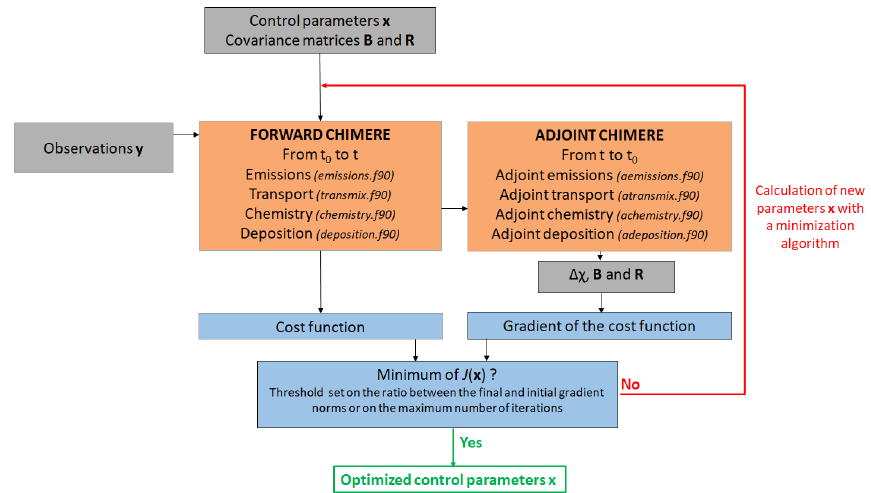
Figure 1. Simplified scheme of the iterative minimization in PYVAR-CHIMERE. PYVAR, CHIMERE and text sources are displayed in blue, in orange and in grey,